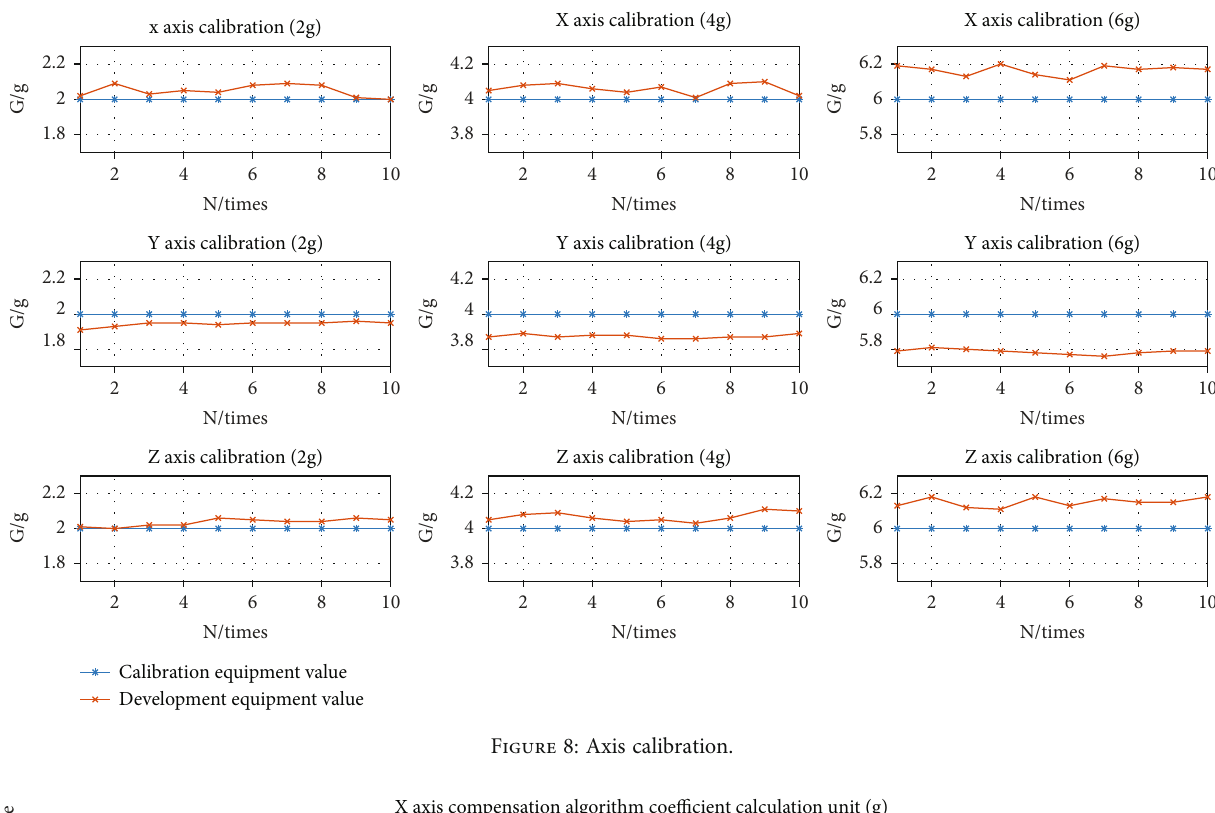
Figure 8: Axis calibration. X axis compensation algorithm coefficient calculation unit (g) y = 0.9717 x + 0.0243 R 2 = 0.9998a = 0.9717, d1 = 0.0243